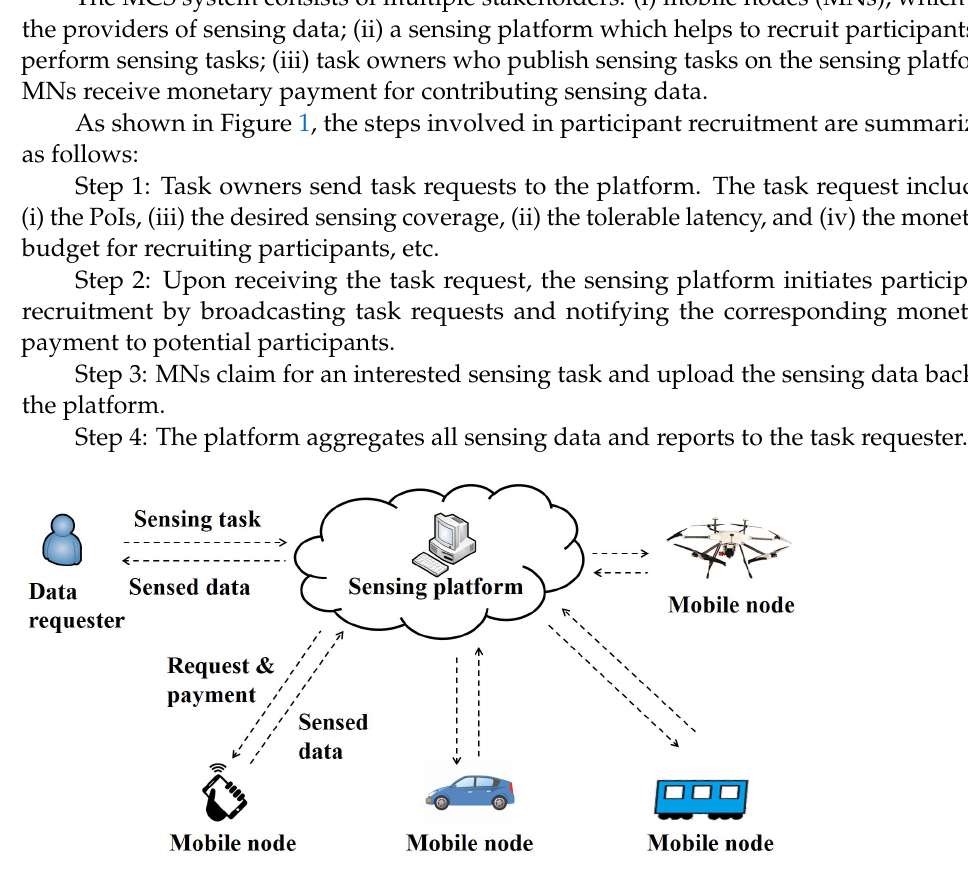
Figure 1. Pre-contracting incentive